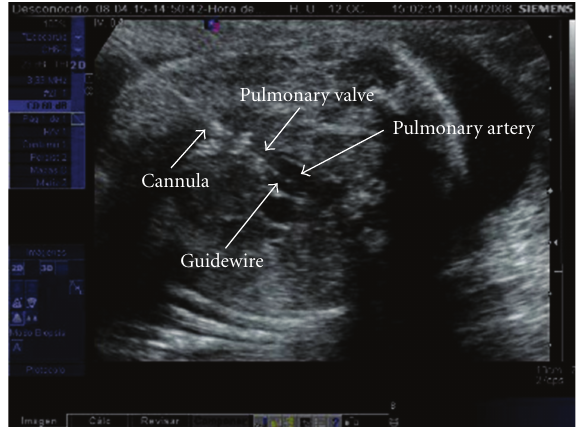
Figure 2: The guidewire has crossed the pulmonary valve, and it is inside the main pulmonary artery.